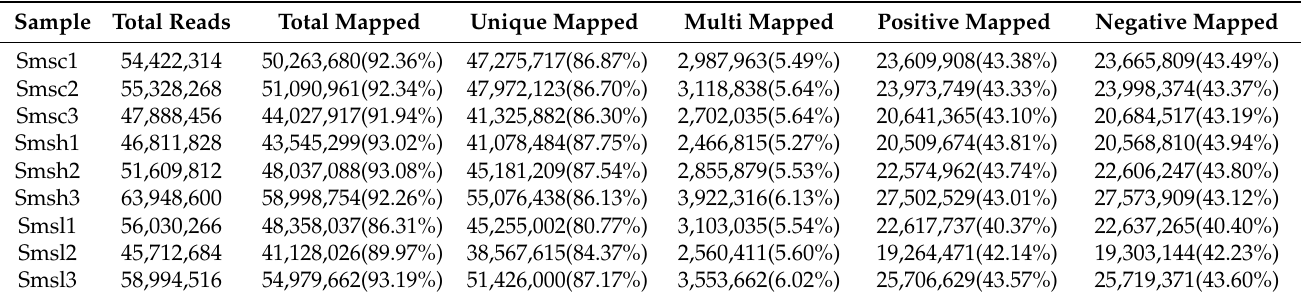
Table 3. Statistics of comparison between sample and reference genome.